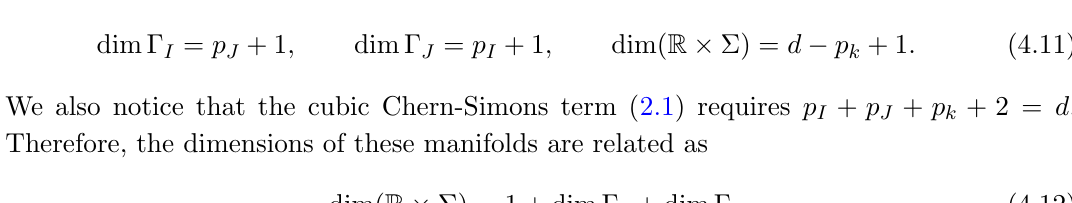
Figure 4 . Left: by adding uphysical pieces to the world volumes represented by dashed lines, M and M J form closed submanifolds. Right: two closed submanifolds M I and M J have a nontrivial